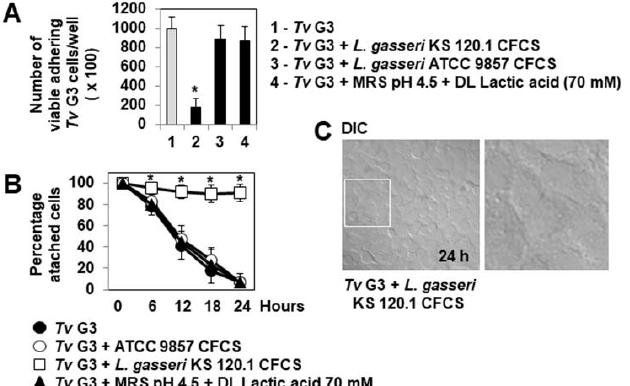
Figure 5. The strain-specific anti-trichomonadal activity of secreted L. gasseri KS 120.1 products abolishes Tv G3-induced cell detachment. In ( A ), quantification of viable parasites adhering to HeLa cells. In ( B ), progression of cell detachment over the course of infection. In ( C ), representative differential interference contrast micrographs of cells. The micrographs shown are representative of three independent experiments. CFCS: cell-free culture supernatant. Each value shown is the mean ± SD of two experiments. In ( A , B ), * p < 0.01 for comparisons with Tv G3.